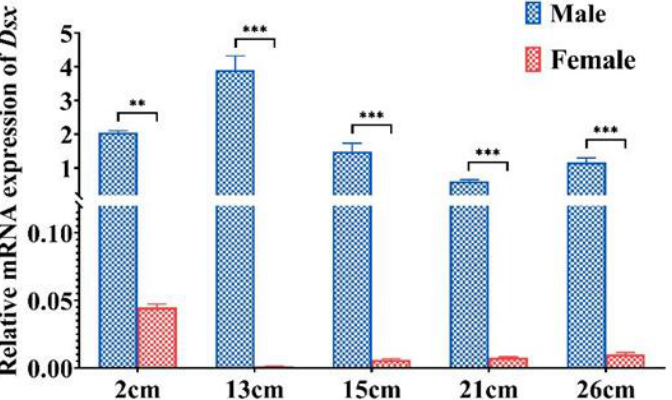
Figure 5. Expression of PmDsx in males and females at different developmental stages.